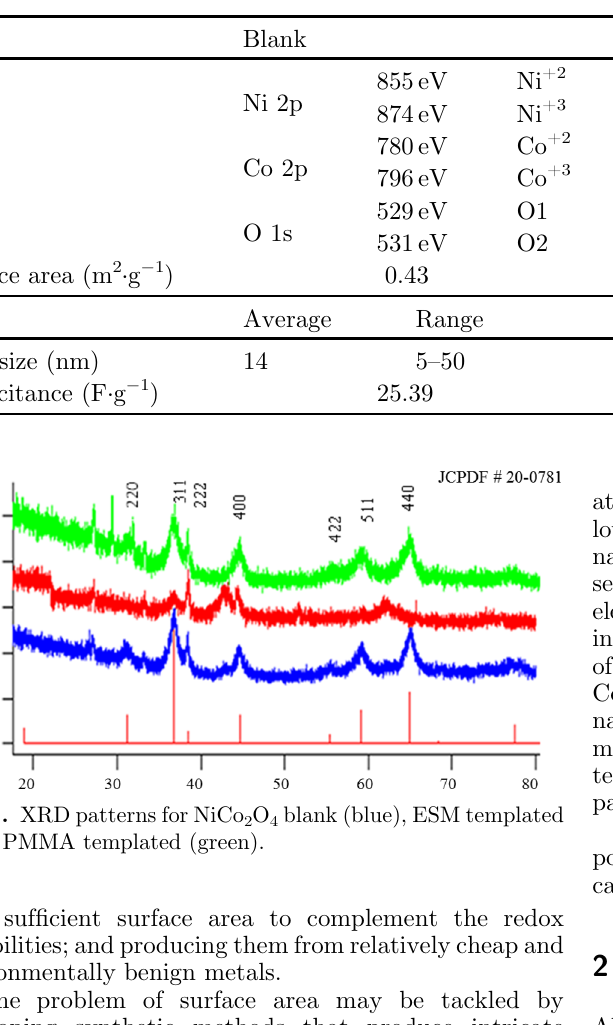
Table 1. Summary of surface chemistry and electrochemical data for NiCo the best performing material.